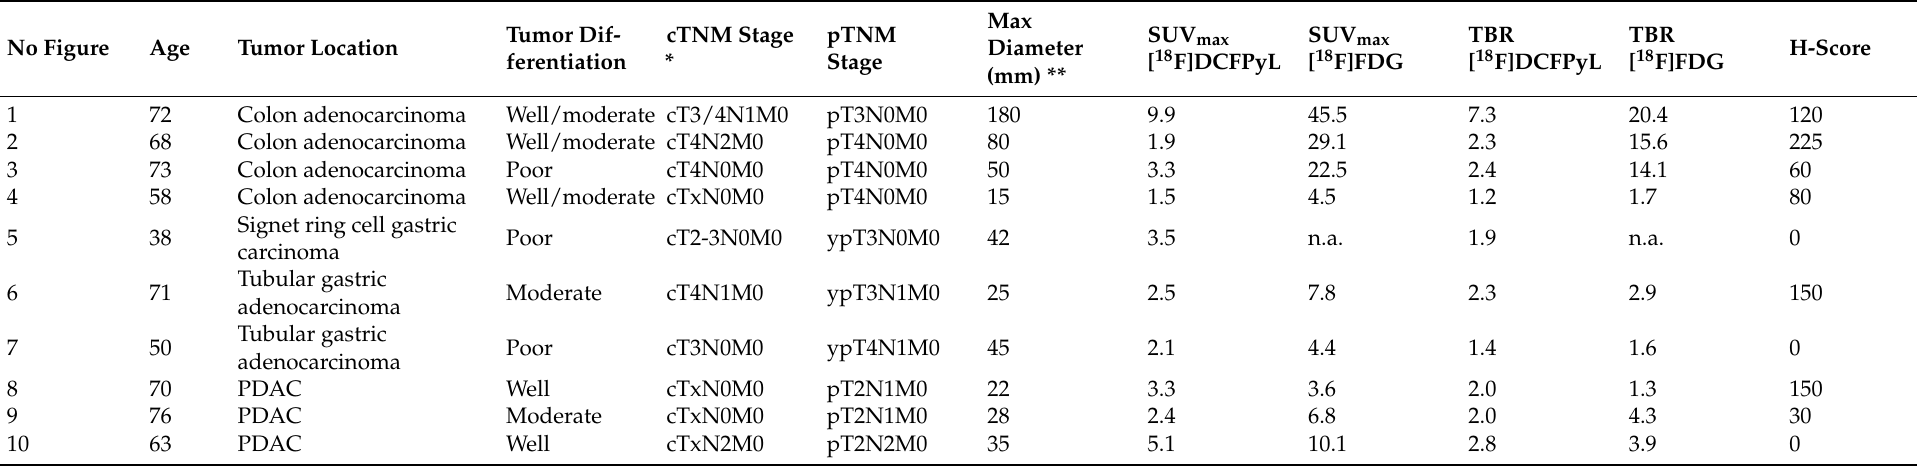
Table 1. Overview of patient